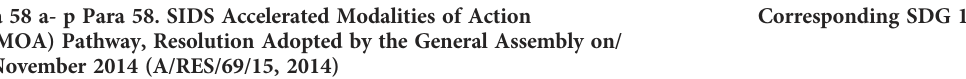
TABLE 2 Macro-level policy analysis of SIDS oceans and seas goal and correlating SDG 14 negotiate text highlighting SDG 14.7 and 14.b policy positionality holistically across island governmental tasks. SAMOA Pathway Text: SIDS